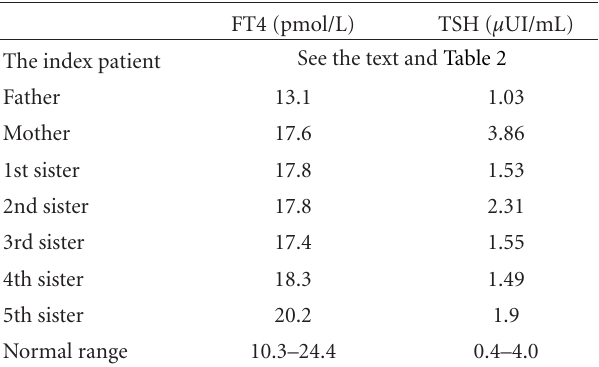
Table 1: Biochemical findings of the family members.